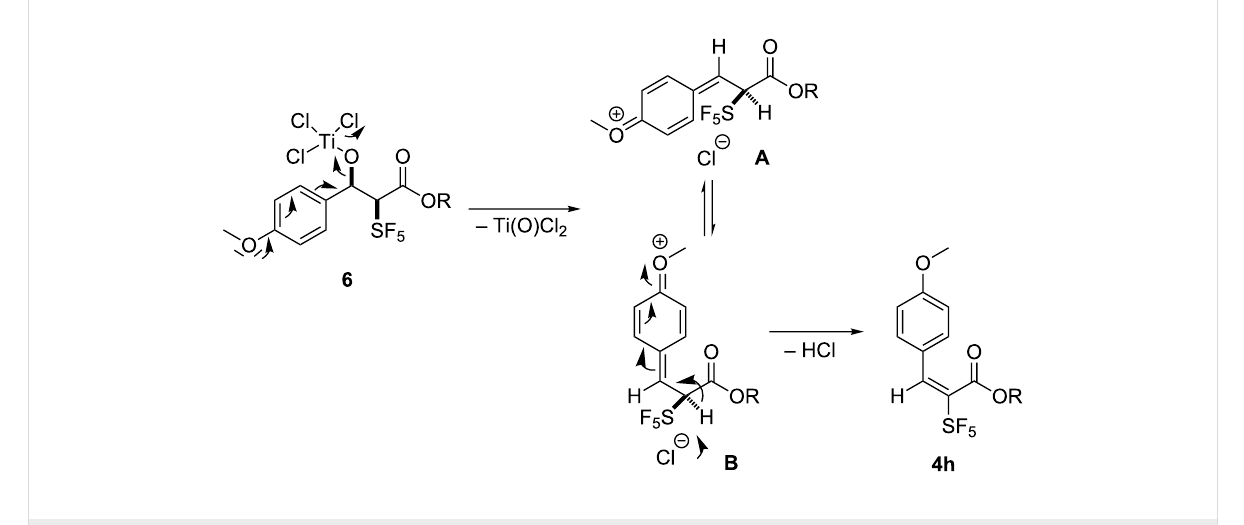
Scheme 4: Anticipated mechanism of formation of aldol condensation products.